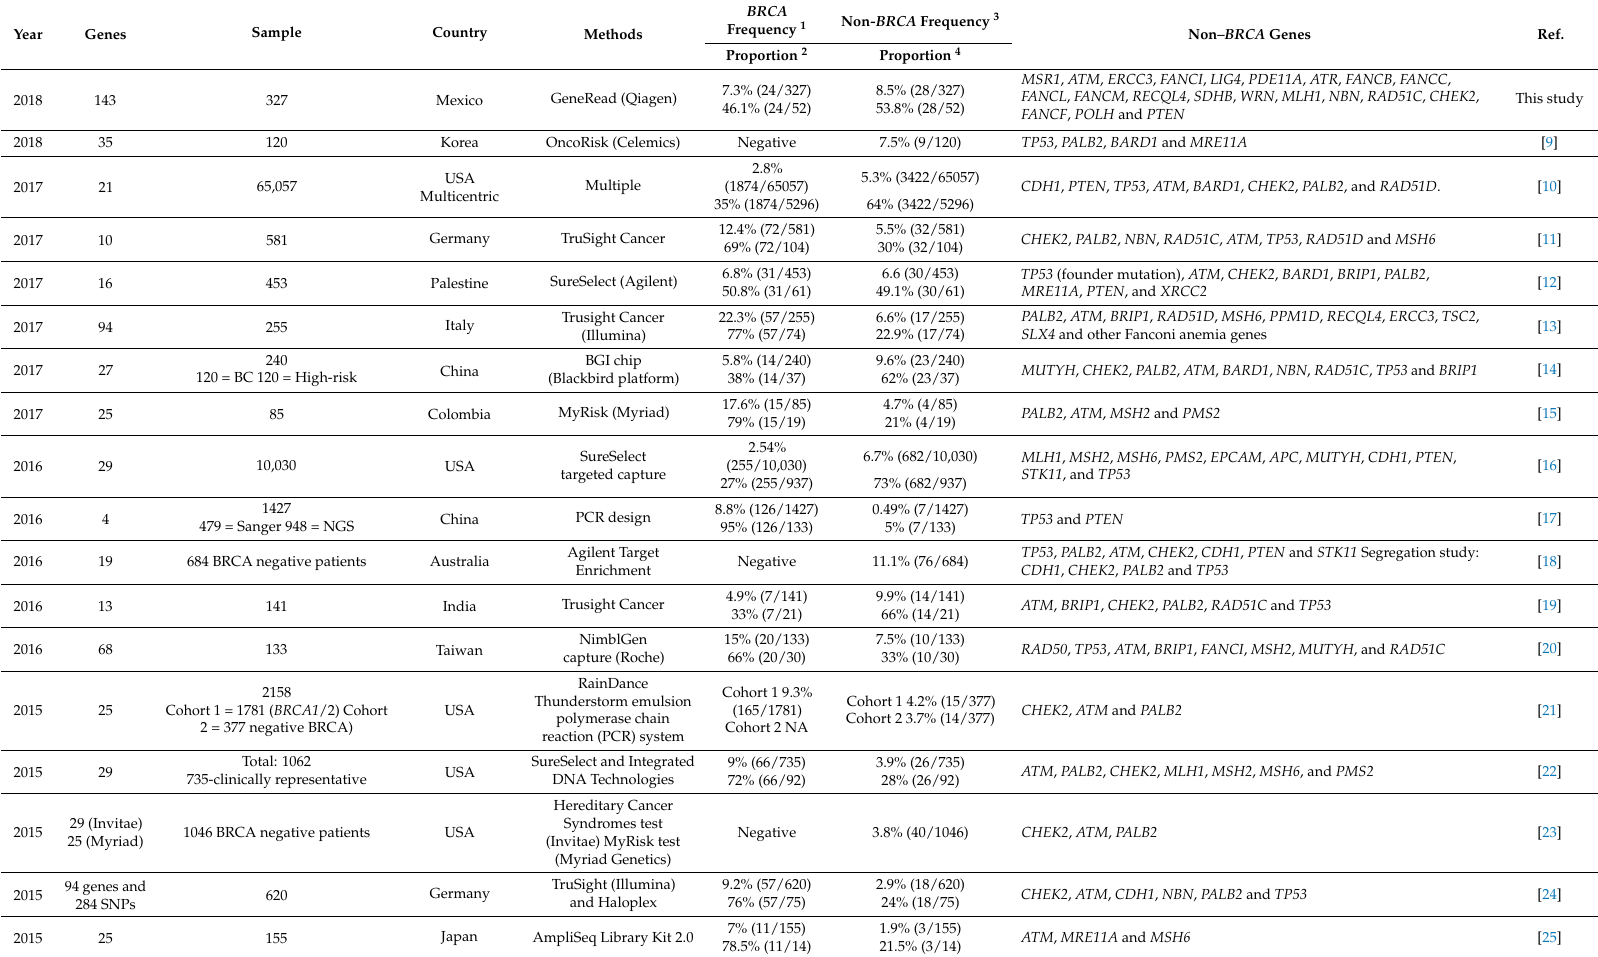
Table 1. Summary of gene panel studies in hereditary breast